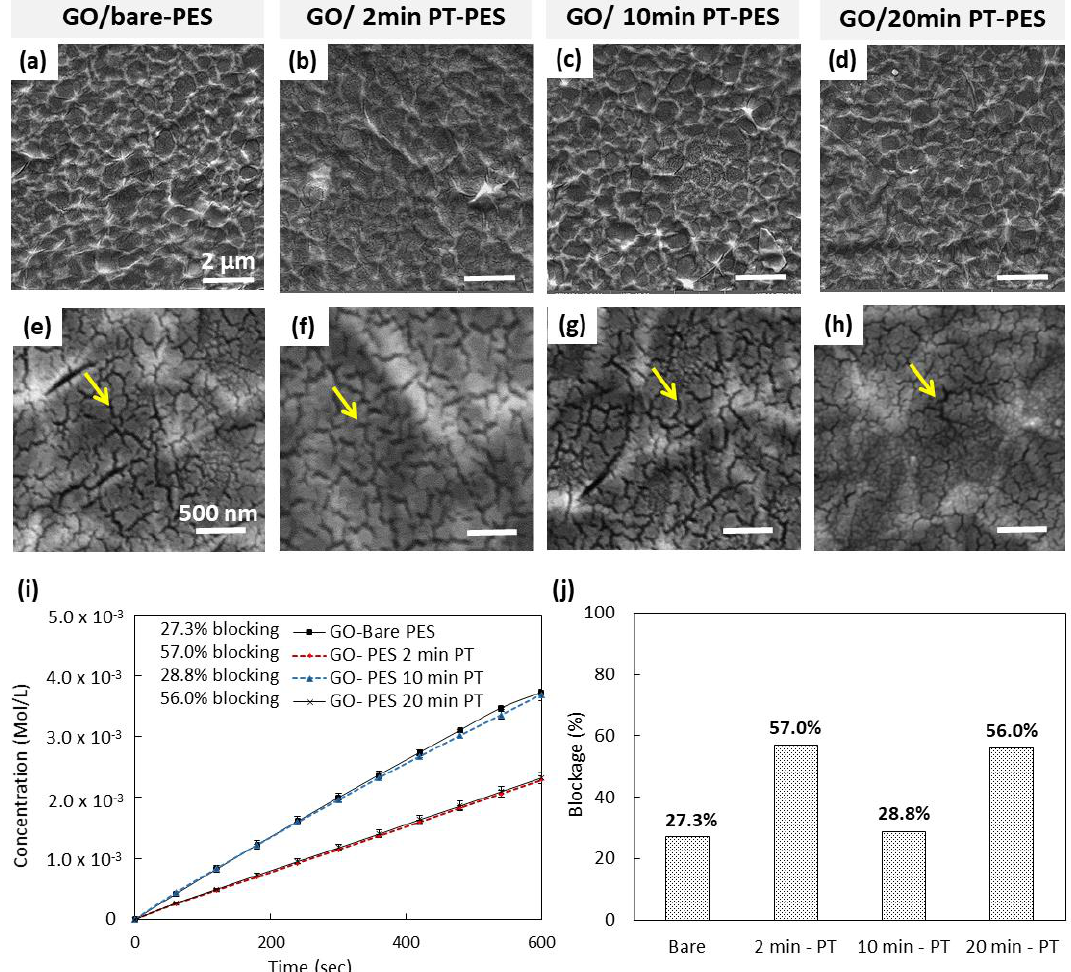
Figure 5. Surface morphology and KCl ions di ff usion study for the developed GO-based membranes at di ff erent PT times. SEM micrographs of ( a , e ) GO / bare-PES, ( b , f ) GO / 2 min PT-PES, ( c , g ) GO / 10 min PT-PES, ( d , h ) GO / 20 min PT-PES. ( i ) Di ff usion test results of the GO / PT-PES samples and ( b ) KCl ion rejection percent (%). Yellow arrows in the SEM images indicate the induced cracks in the GO layer due to water evaporation.